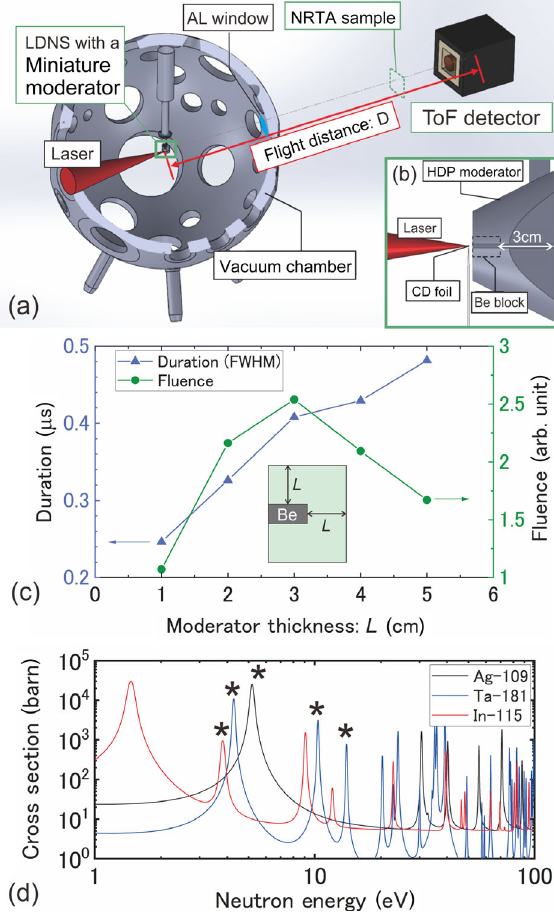
5. (a,b) Schematic pictures of the NRTA beamline (a) and the miniature moderator (b) installed on the LDNS. (c) Simulated results of pulse duration and fluence of 10-eV neutrons at the exit of the moderator as a function of the moderator thickness. (d) Cross sections for neutron capture processes of 115 In, 181 Ta, and 109 Ag [42]. The marked peaks are analyzed in the